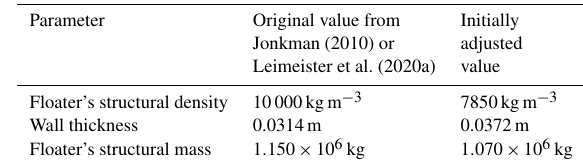
Table 1. Comparison of original and initially adjusted FOWT sys- tem